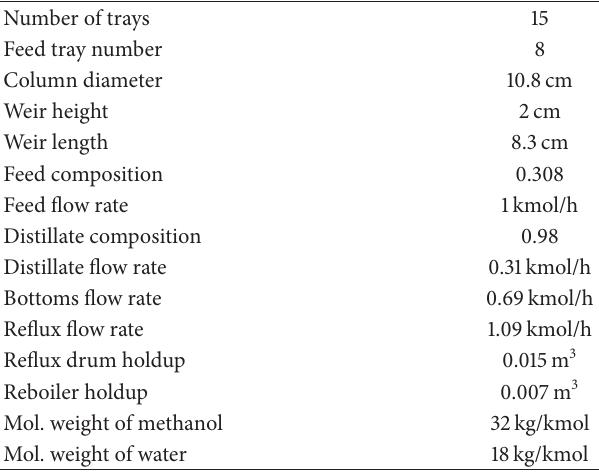
Table 1: Nominal operating conditions and the column parameters. Table 2: Comparison between steady-state experimental and simu- lation results.